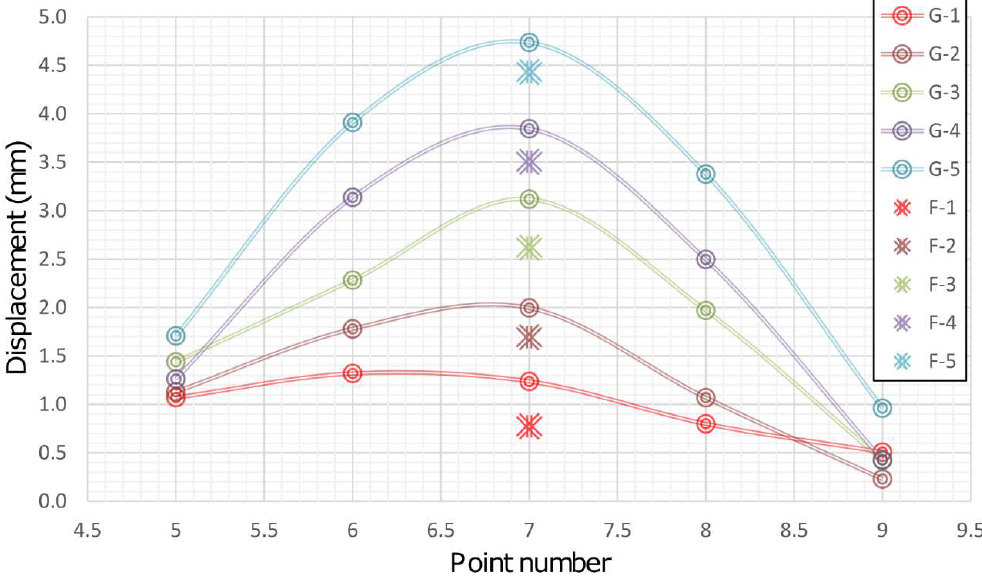
Figure 7. Results of all geodetic and 2D deflection sensor measurements. Sensors 2019 , 19 , x